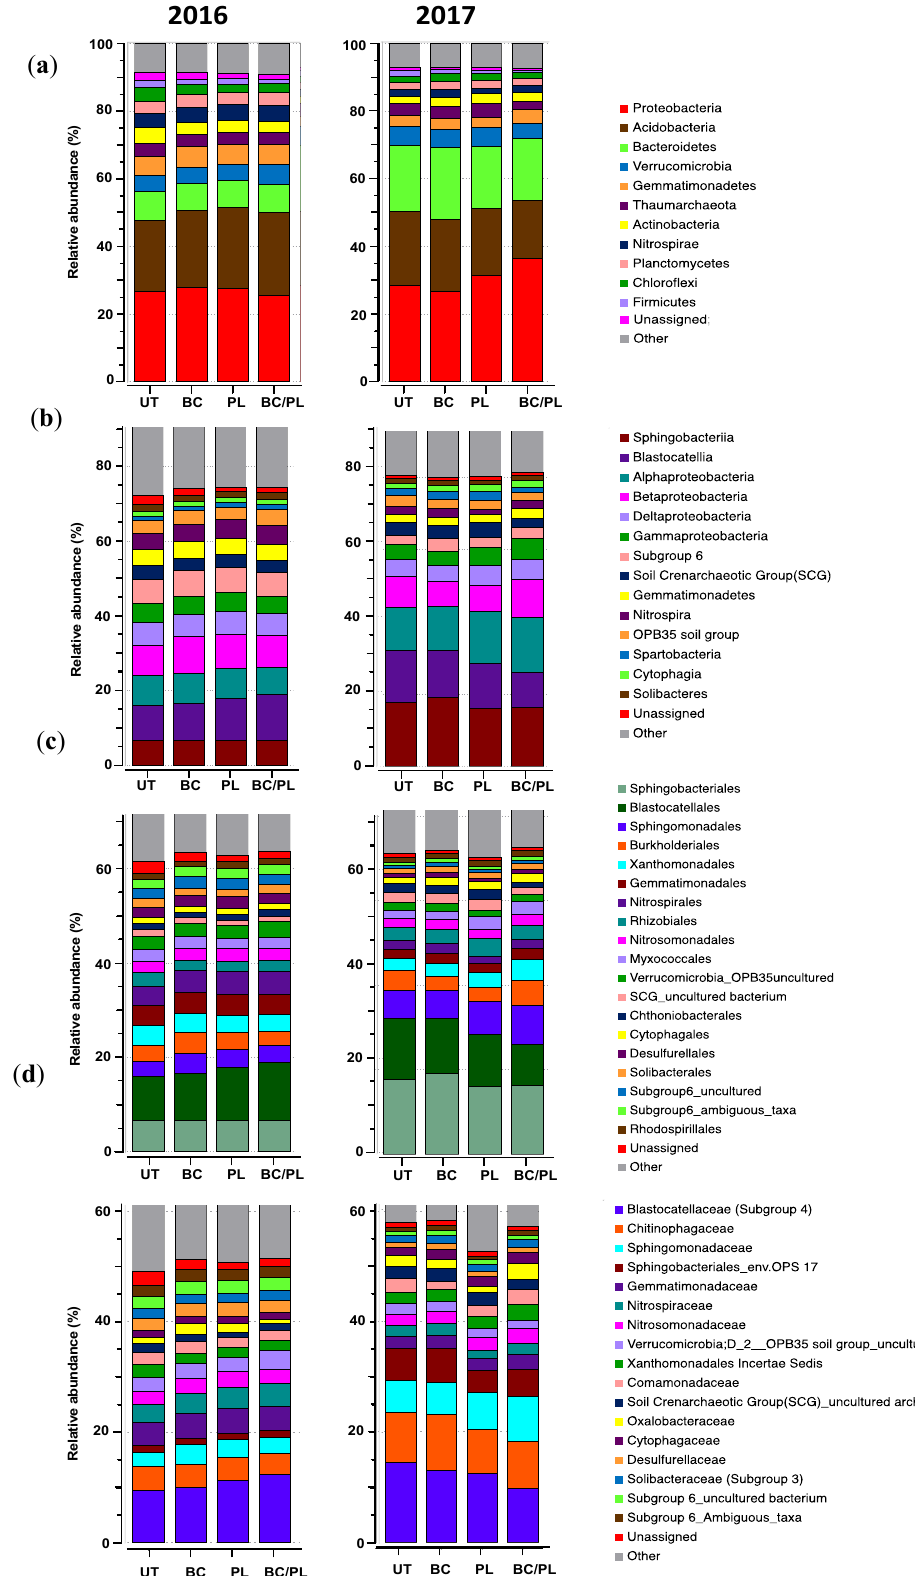
Figure 3. Bacterial taxonomic composition of the treated and untreated soils at the: ( a ) phylum, ( b ) class, ( c ) order, and ( d ) family levels as influenced by different soil treatments over the 2 growing seasons.